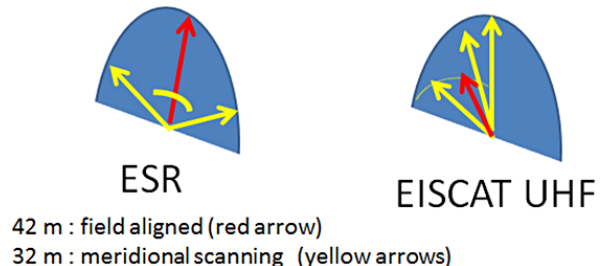
Figure 4. Schematic illustration of the beam directions of the ESR and EISCAT UHF radar employed in the present study. The 42m antenna of the ESR was pointed in the field-aligned direction (red arrow in the left panel), while the 32m antenna of the ESR was run in the geomagnetic meridional plane (yellow arrows in the left panel). The EISCAT UHF radar pointed in the direction of the geo- graphic meridional plane (yellow arrows in the right panel) and had a beam departing 30 ◦ azimuthally from the meridional plane (red arrow in the right